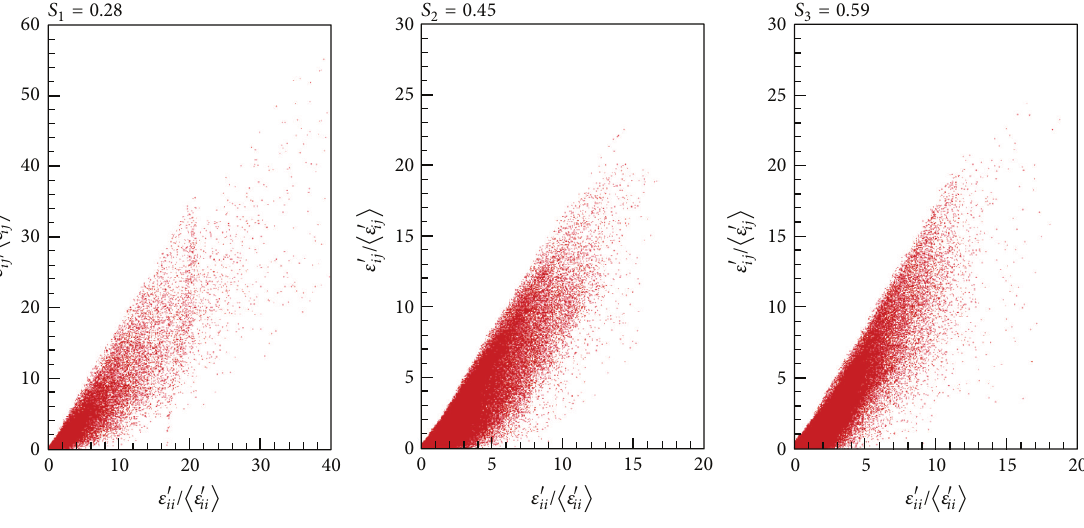
Figure 3: Relation of the components of the dissipation tensor 𝜀 𝑖𝑗 ( 𝜀 𝑖𝑖 in the 𝑥 -axis and 𝜀 𝑖𝑗,𝑖 ̸=𝑗 in the 𝑦 -axis, with 𝜀 𝑖𝑖 = 𝜀 11 + 𝜀 22 + 𝜀 33 and 𝜀 = 2{|𝜀 | + |𝜀 | + |𝜀 |} , normalized by the root-mean-square values ⟨𝜀 󸀠 𝑖𝑗,𝑖 ̸=𝑗 12 13 23